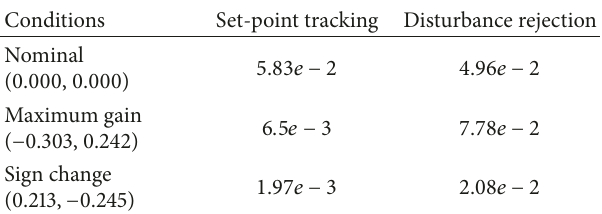
Table 4: Summary of ISE for Case